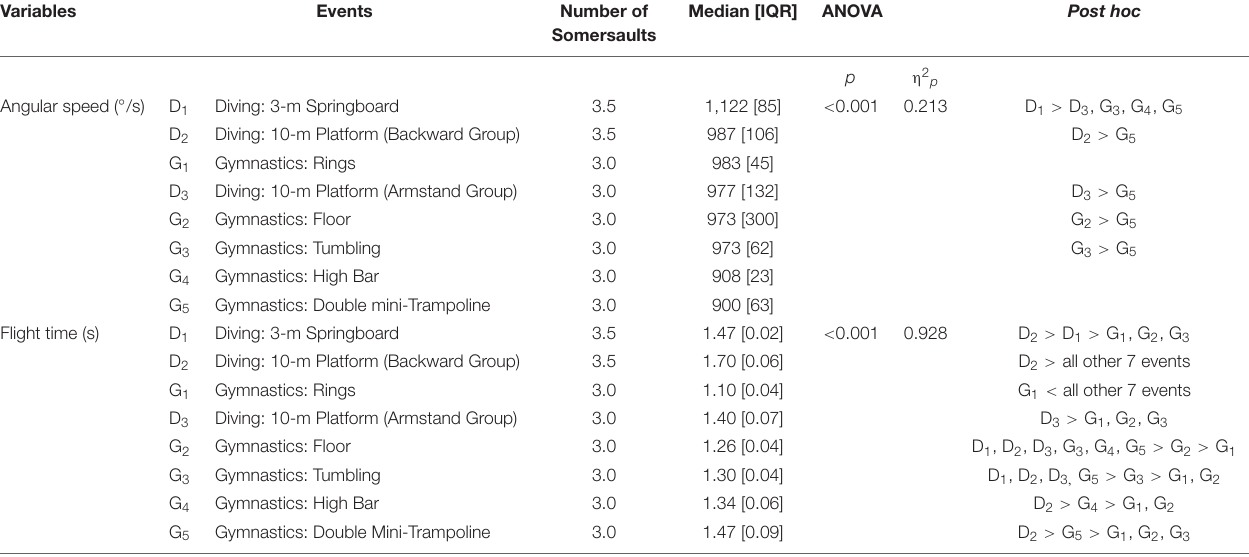
TABLE 1 | Angular speed and flight time of multiple back somersaults in diving and gymnastics events. Variables Events Number of